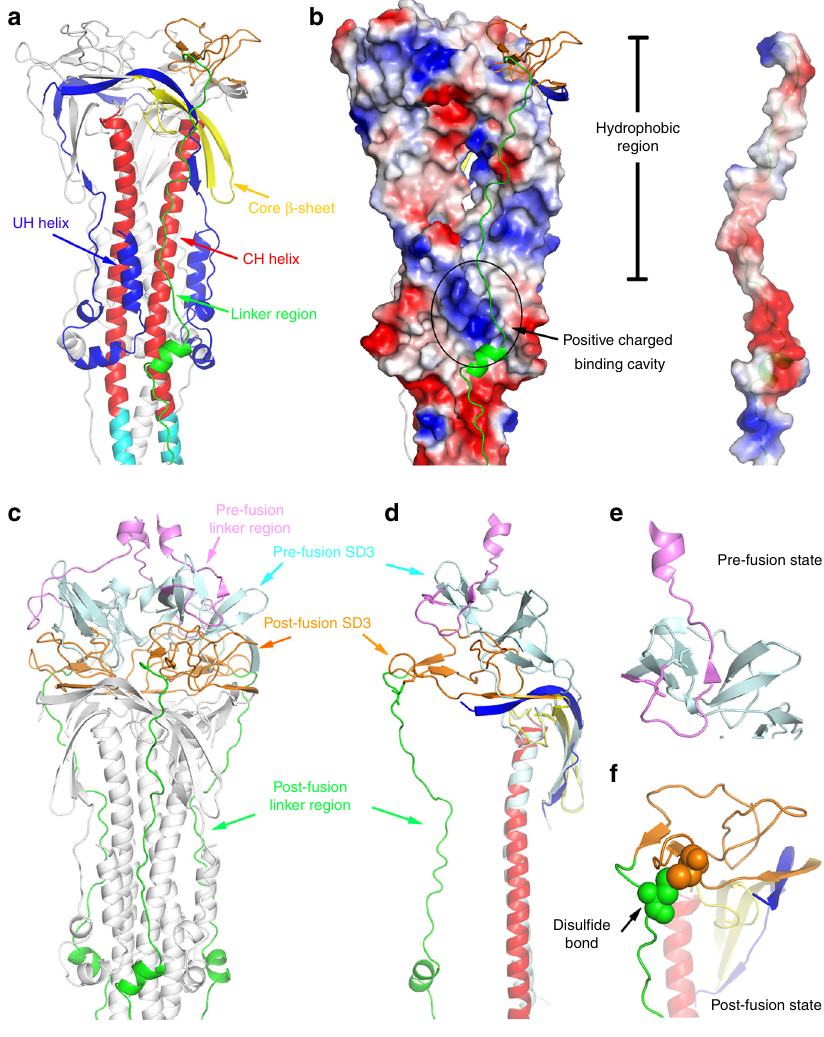
Fig. 3 The linker region upstream of HR2 motif important for membrane fusion. a Binding of the linker region upstream of HR2 motif along the central helix colored as in Fig. 1a. b The electrostatic surface representation of the linker region upstream of HR2 motif binding area. Red represents negative charge, and blue represents positive charge. c Overall structural changes of the linker region upstream of the HR2 motif during membrane fusion. The linker regions in pre-fusion 20 (PDB: 6NB6) and post-fusion states are shown as cartoons colored in violet and green, respectively. The SD3 domains in pre- fusion 20 (PDB: 6NB6) and post-fusion states are shown as cartoons colored in pale cyan and orange, respectively. d Structural changes of the linker region upstream of the HR2 motif during membrane fusion represented in single chain mode. The cartoons are colored as in ( c ). e Structural details of the linker region and the SD3 domain from the pre-fusion SARS-CoV 20 (PDB: 6NB6) colored as in ( c ). f Structural details of the linker region and the SD3 domain from the post-fusion SARS-CoV colored as in ( c ). The disul fi de bond is shown as